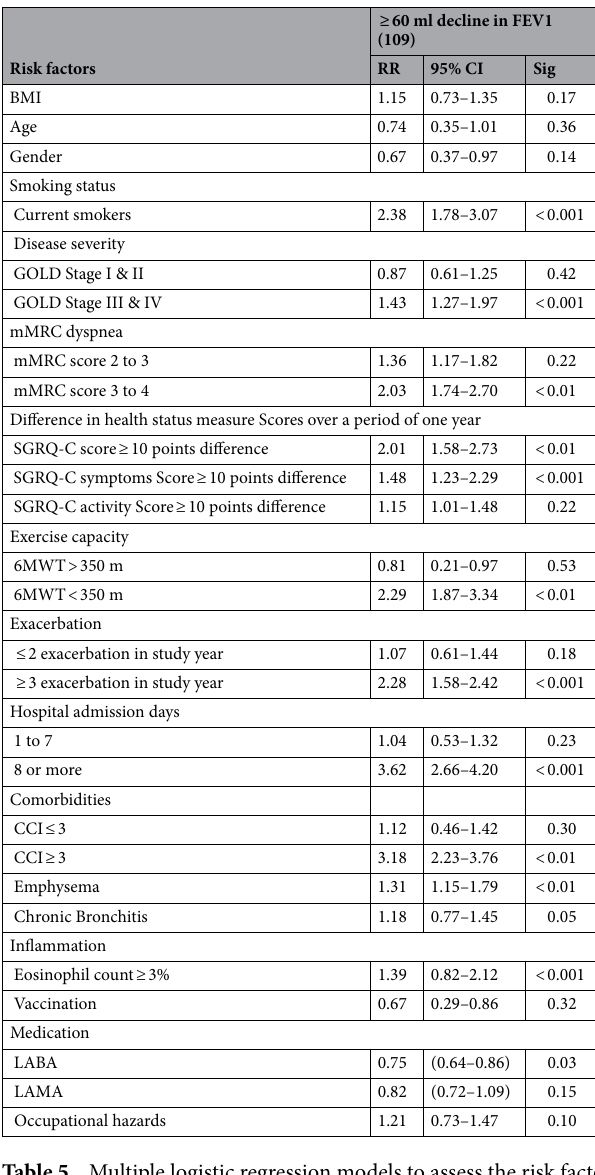
Table 5. Multiple logistic regression models to assess the risk factors associated with ≥ 60 ml decline in FEV 1 in COPD patients. BMI, body mass index; CI, confidence interval; COPD, Chronic Obstructive Pulmonary Disease; CCI, Charlson comorbidity Index; FEV 1 , forced expiratory volume in 1 second; FVC, forced vital capacity; FEV 1 %, percentage predicted FEV1; GOLD, global initiative for Chronic Obstructive Lung Disease; GOLD I